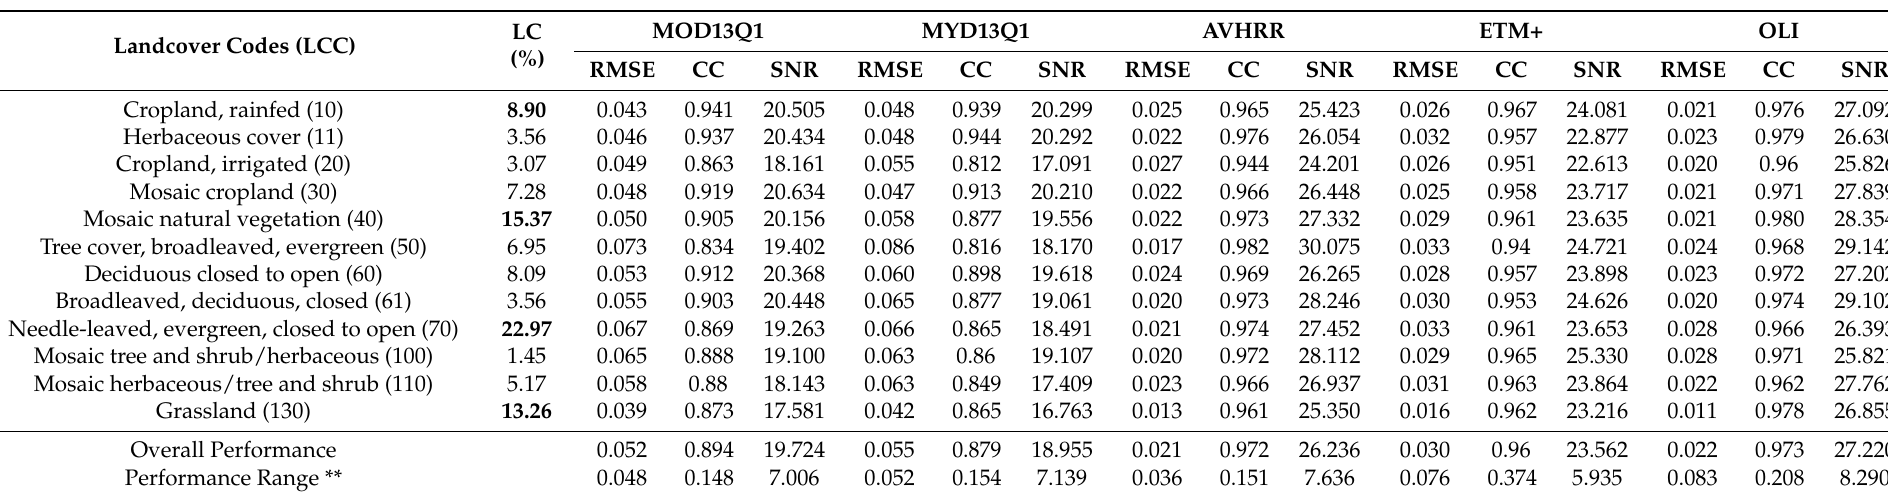
Table 3. Statistical analysis of localized performance in five different sensors (MOD, MYD, AVHRR, ETM+, OLI) based on mean values of cross-correlation (CC), root mean square (RMSE), and signal to noise ratio (SNR) in different landcover classes over QTP